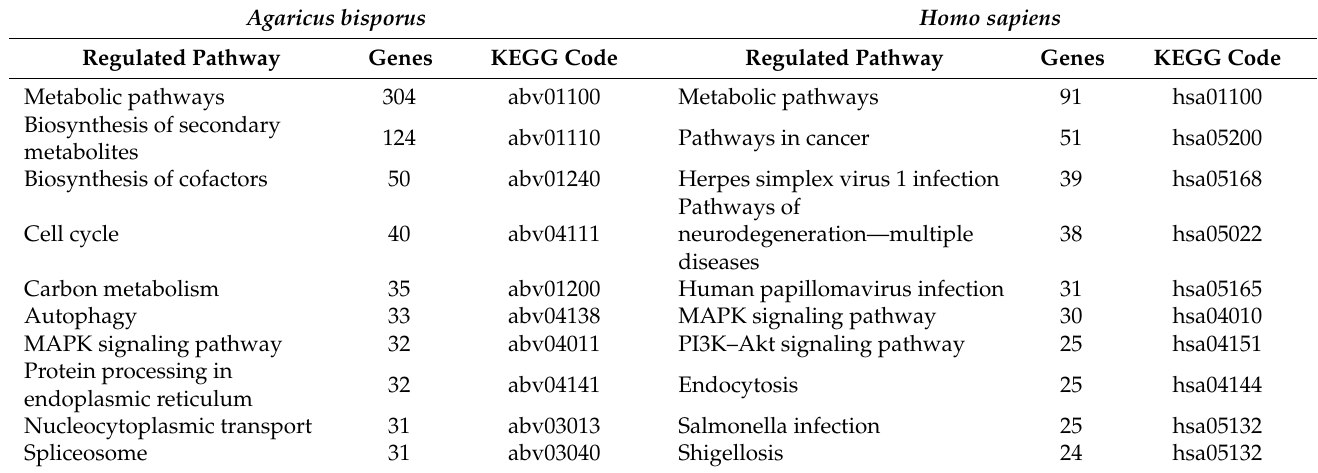
Table 4. Top 10 regulated pathways, by proposed abi_milRNAs, in A. bisporus and H. sapiens according to